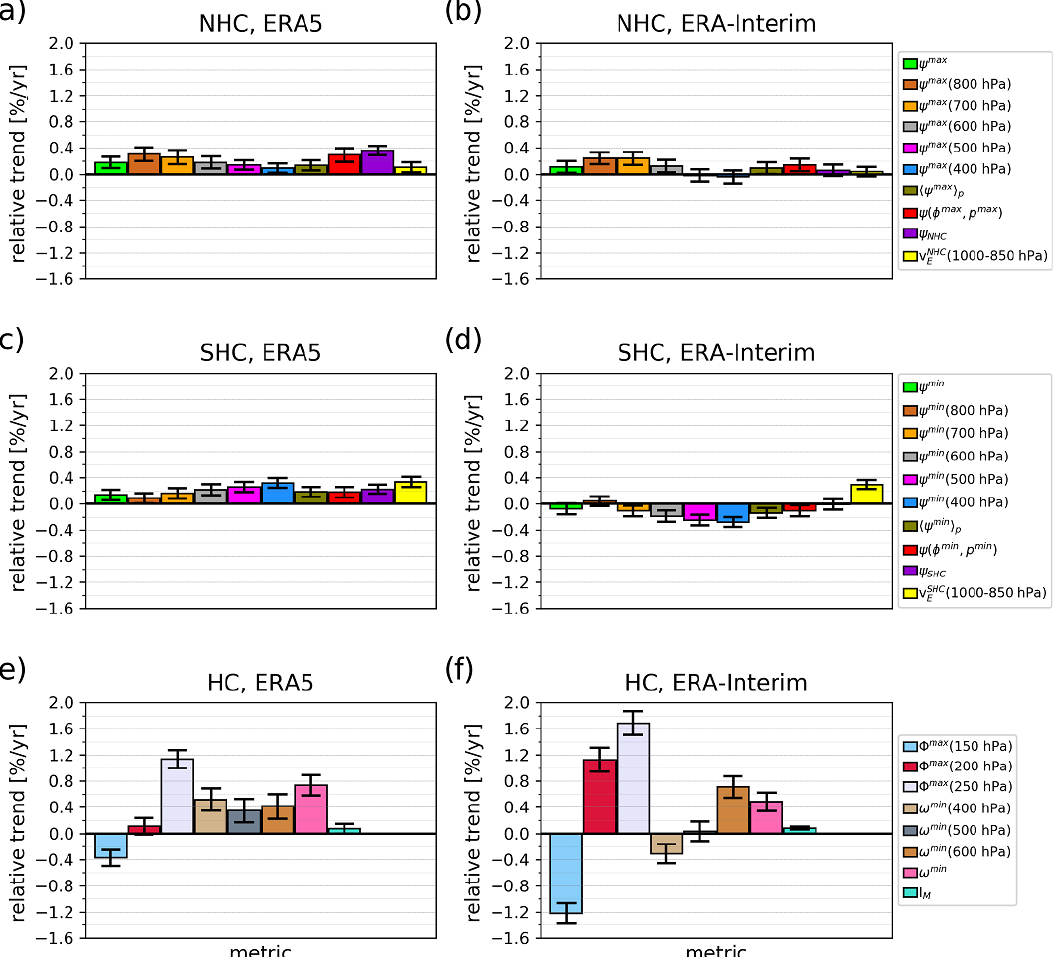
Figure 4. Trends in the annual-mean HC strength normalized by their climatological mean values: for the NHC (a, b) , SHC (c, d) , and total Hadley circulation (e, f) ; in ERA5 (a, c, e) and ERA-Interim (b, d, f) reanalyses between 1979 and 2018 for different metrics of HC strength defined in Sect. 2.2; see also Fig. 3. Note that positive values in all panels indicate strengthening of NHC and SHC. Black error bars indicate the standard error of the trend